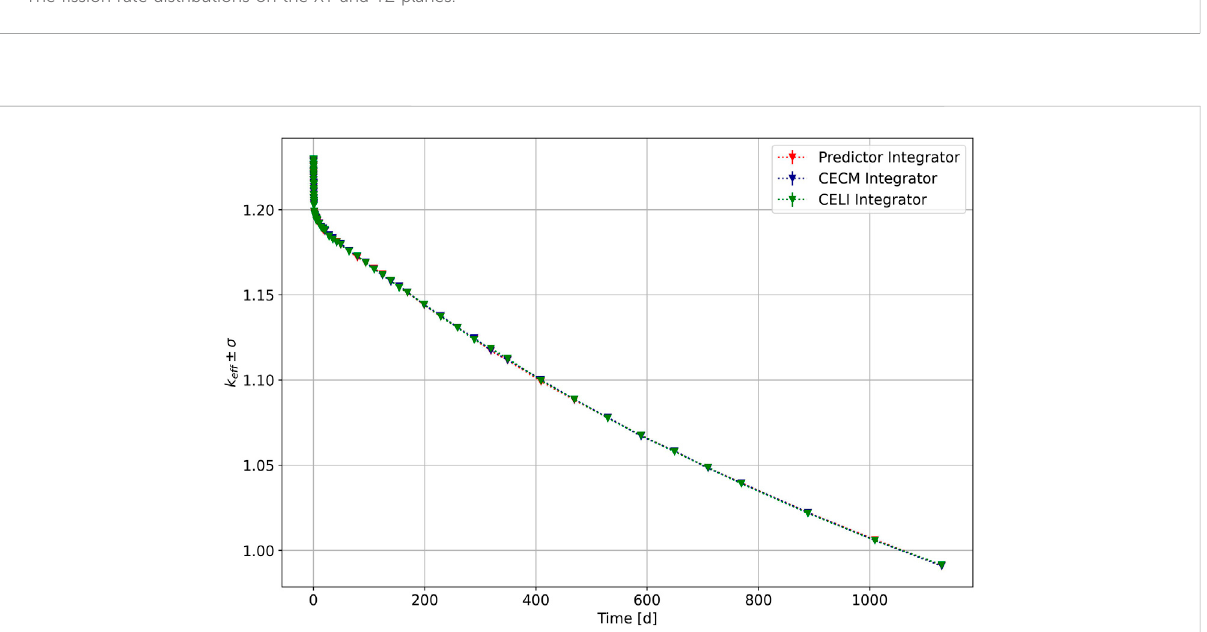
FIGURE 10 The fi ssion rate distributions on the XY and YZ planes.